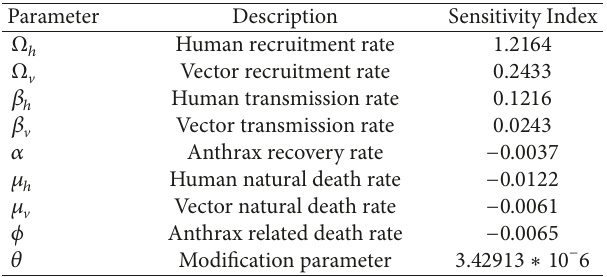
Table 1: Sensitivity indices of R 0𝑎 to each of the parameter